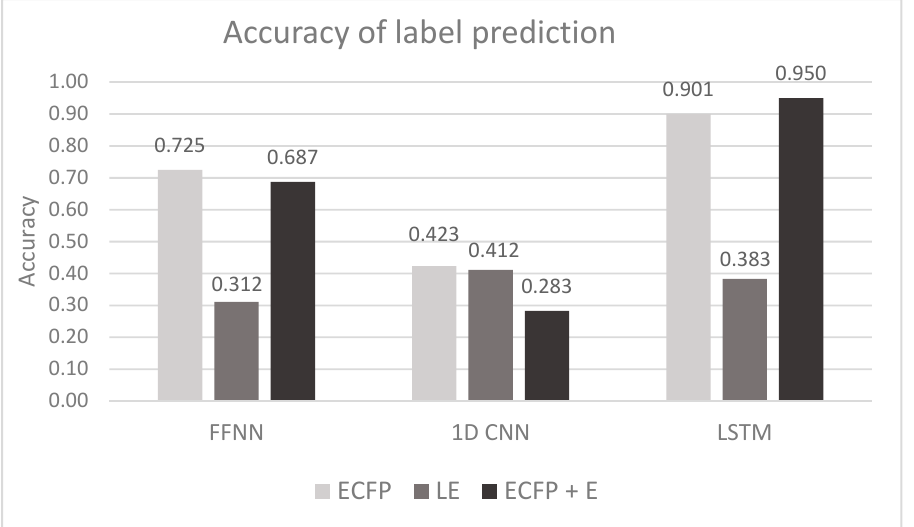
Figure 2. Accuracies with different vectorization types and methods for task No. 1. The majority baseline is equal to 0.313.